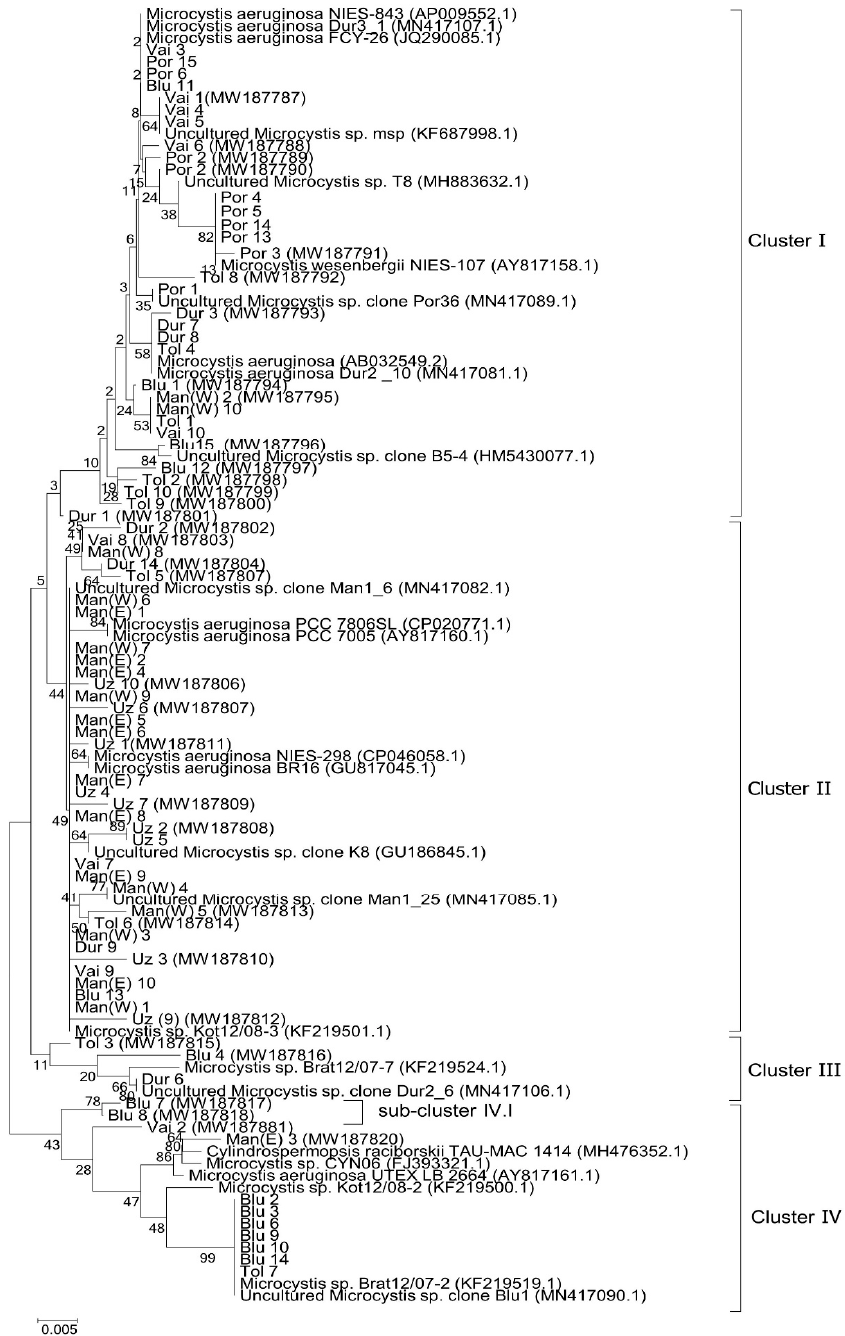
Figure 7. Neighbor-joining phylogenetic tree constructed using nucleotides sequences from eight library samples and closest sequences retrieved after BLAST search in NCBI database with indication of their accession number in NCBI. Bootstrap values are shown at branch points (percentage of 1050 resamplings). Legend: Tol—Reservoir Izvornik 2